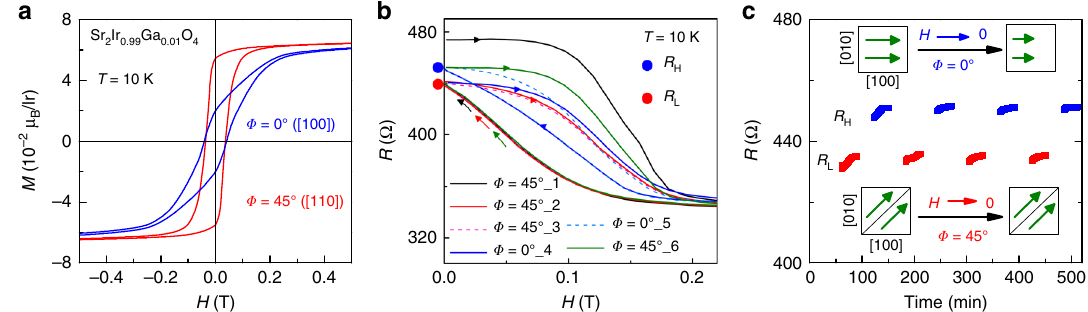
Fig. 4 Nonvolatile memory and the in-situ control. a Measured M ( H ) curves at Φ = 0 o and Φ = 45 o at T = 10 K for 1%-Ga doped Sr 2 IrO 4 , in which different remnant magnetization can be seen. b R ( H ) curves measured by successive H cycling along different directions at T = 10 K. For instance, Φ = 0 o _1 means the fi rst H -cycle at Φ = 0 o . The fi eld sweeping direction is indicated by arrows. The blue and red dots represent the high ( R H ) and low ( R L ) resistance state which can be switched by H -cycling. c Stable and reproducible memory states in-situ controlled by H at T = 10 K. The corresponding net moment arrangements are schematically shown in the inset. In comparison with the case at Φ = 45 o , smaller net magnetization exists at Φ = 0 o as H